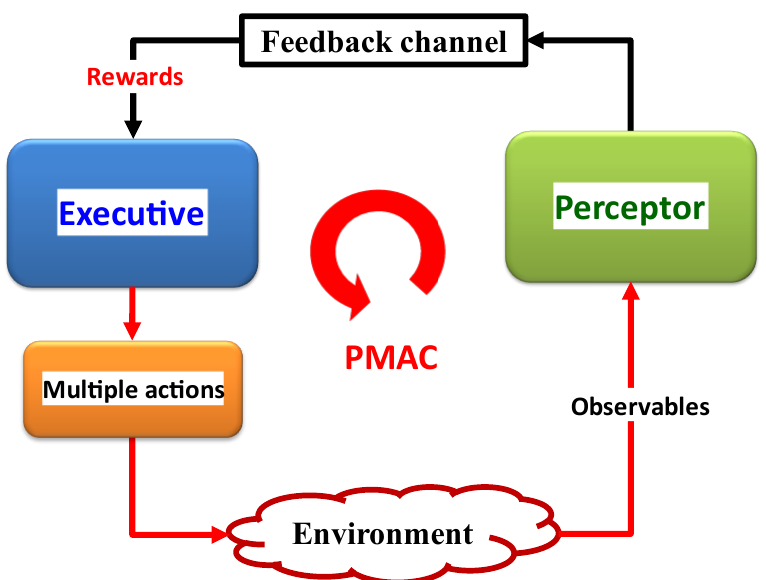
Figure 16. Block diagram of the perception multiple actions cycle-based cognitive dynamic system (CDS).